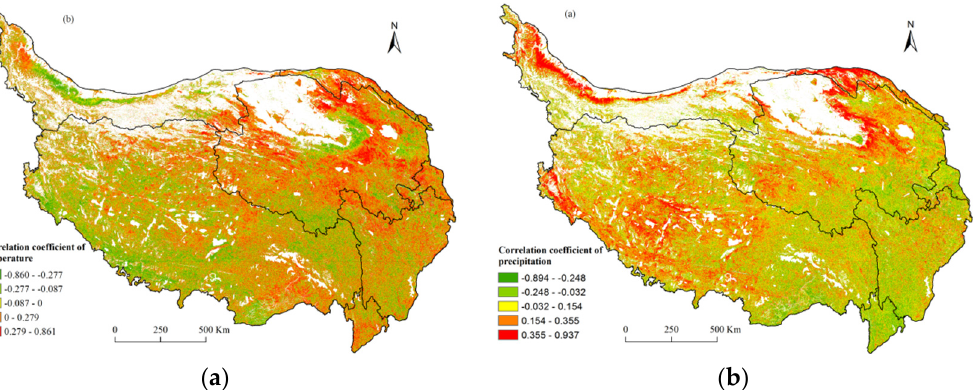
Figure 9. Correlation analysis between FVC and ( a ) temperature and ( b ) precipitation on the Qinghai–Tibet Plateau.